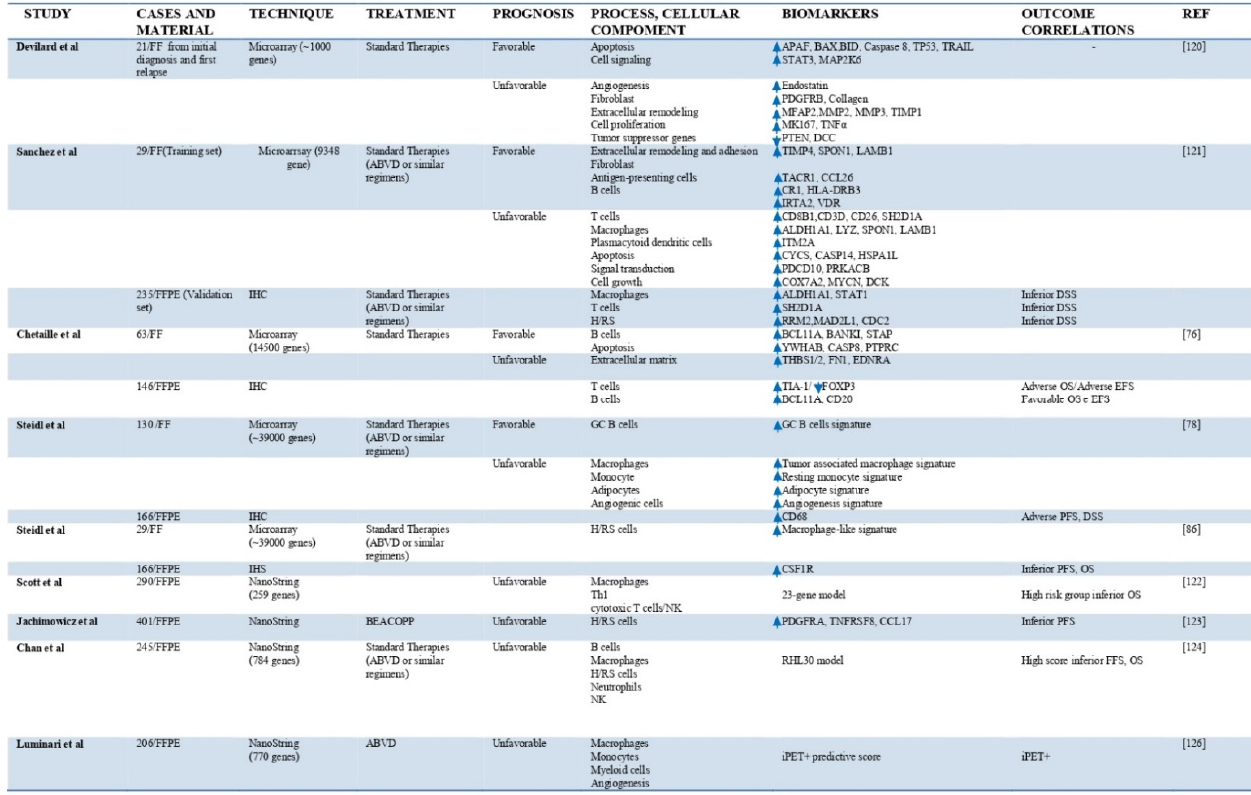
Figure 2. Published studies examining GEP and outcome in classical Hodgkin lymphoma.